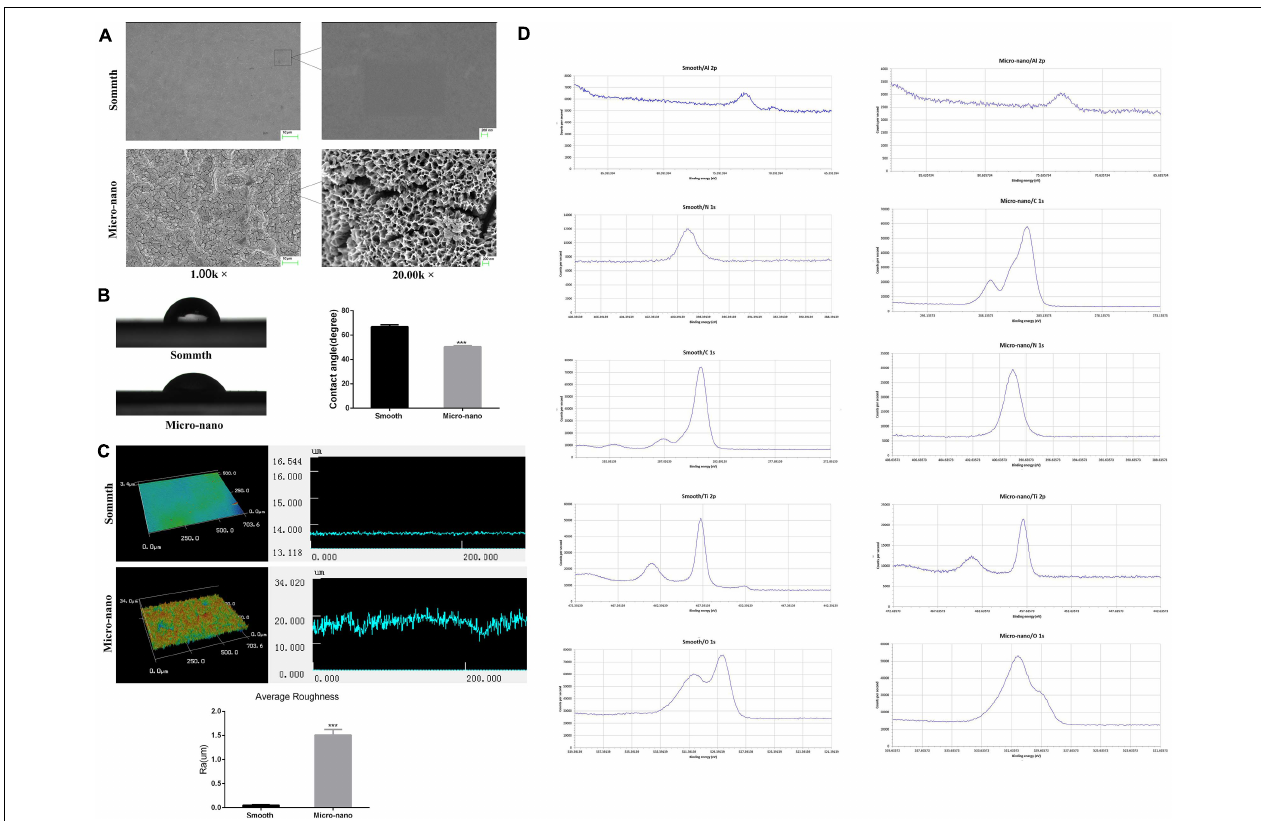
FIGURE 1 | Surface characterization of materials. (A) The surface morphology of titanium disk was observed by using a scanning electron microscope. (B) Contact angle test. (C) Three-dimensional structure diagram observation and roughness test (Yang et al., 2020). (D) XPS analysis (smooth: smooth titanium disk; micro-nano: small-scale topography titanium disk. *** p < 0.001).